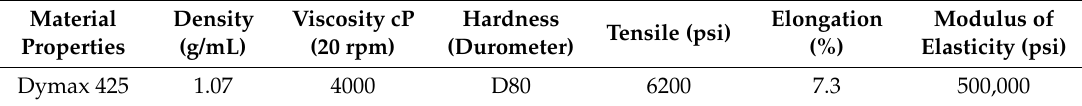
Table 1. Technical specification of the ultraviolet-curable resin used.